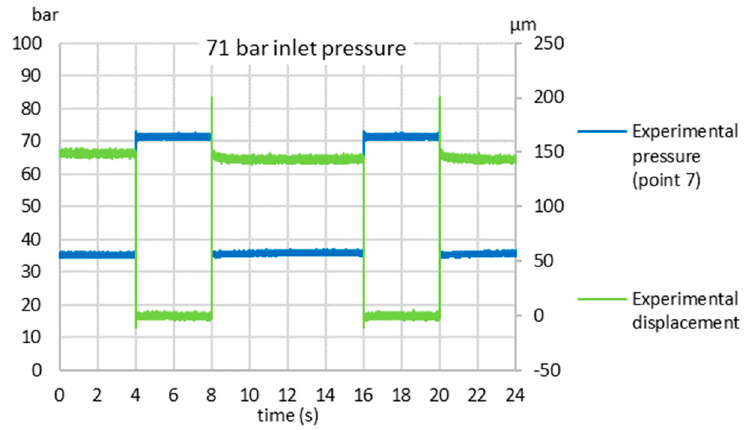
Figure 10. Pressure at point (7) and displacement measured during repeated opening and closing procedures of the piezo-valve.